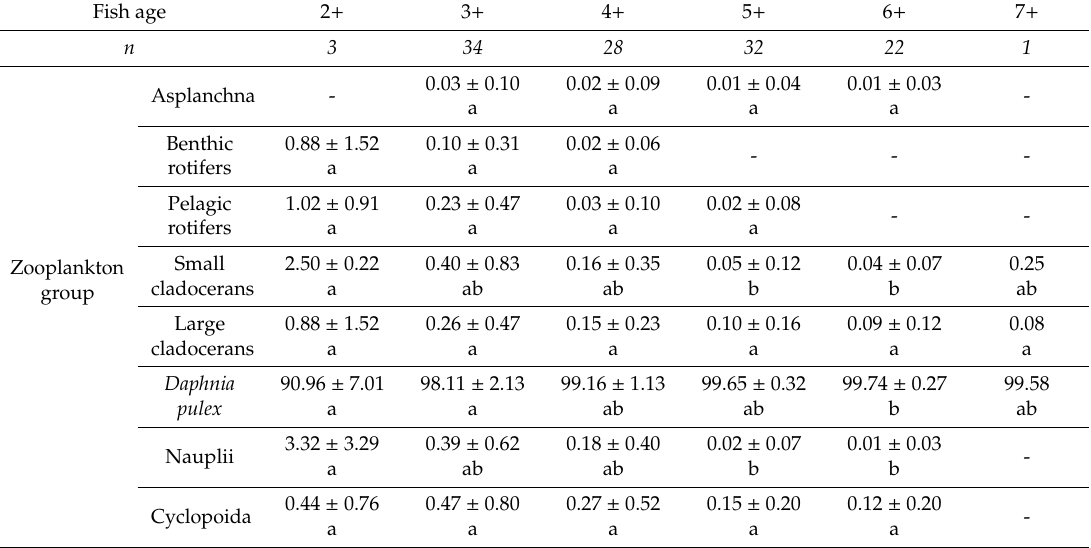
Table 4. Mean values ± SD of percentage contribution of zooplankton abundance in fish stomachs. Di ff erent letters in rows show significant di ff erences between fish-age samples (post-hoc multiple comparisons of mean ranks for all groups p <